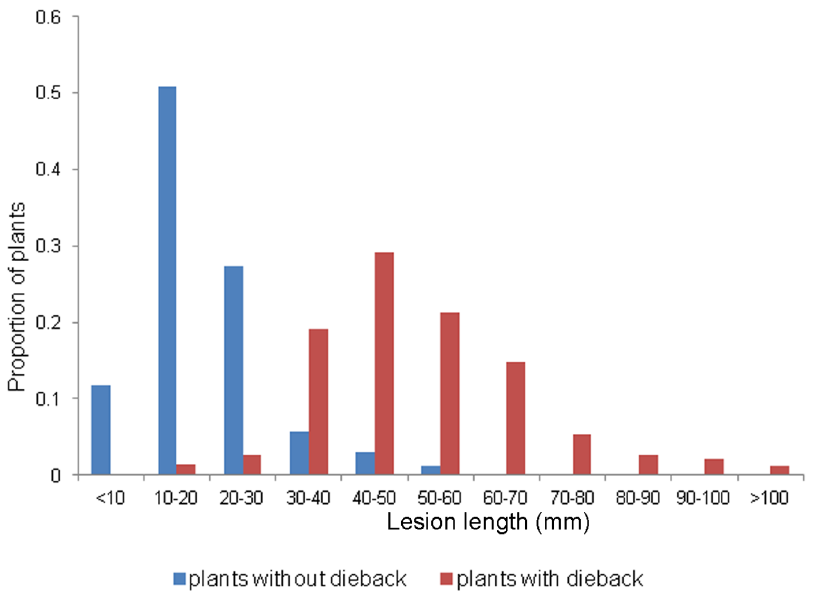
Fig. 1. Proportion of plants of Pinus pinaster inoculated with Fusarium circinatum that did (in red) or did not show (in blue) dieback for intervals of lesion length measured at the sampling date (2013